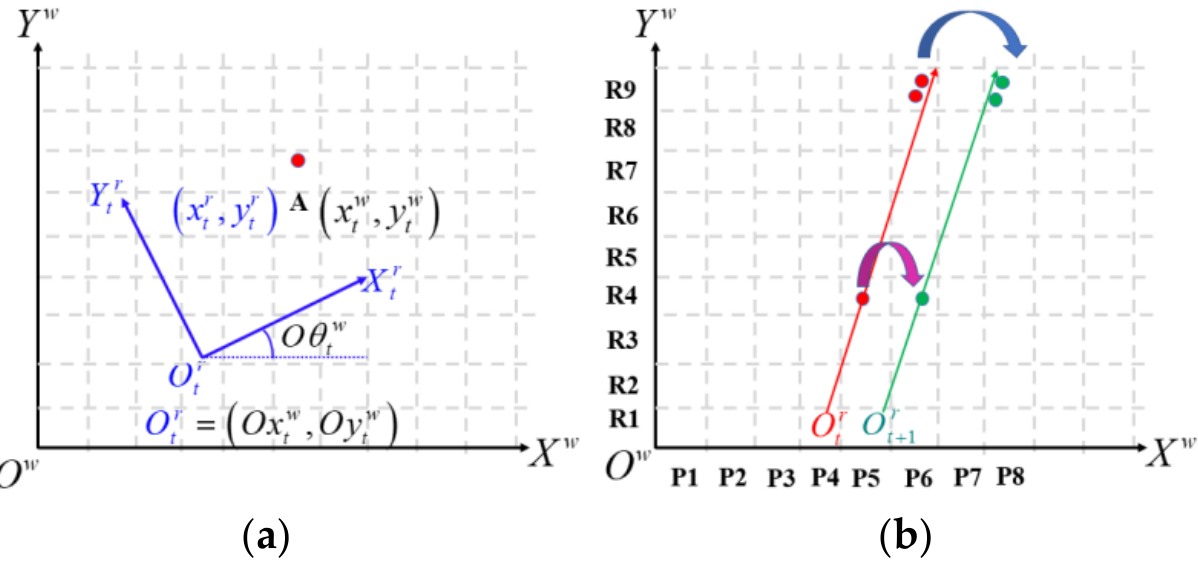
Figure 5. ( a ) Schematic diagram of coordinate system conversion. ( b ) Schematic diagram of the false detection points’ impact on CSM MAP estimation.